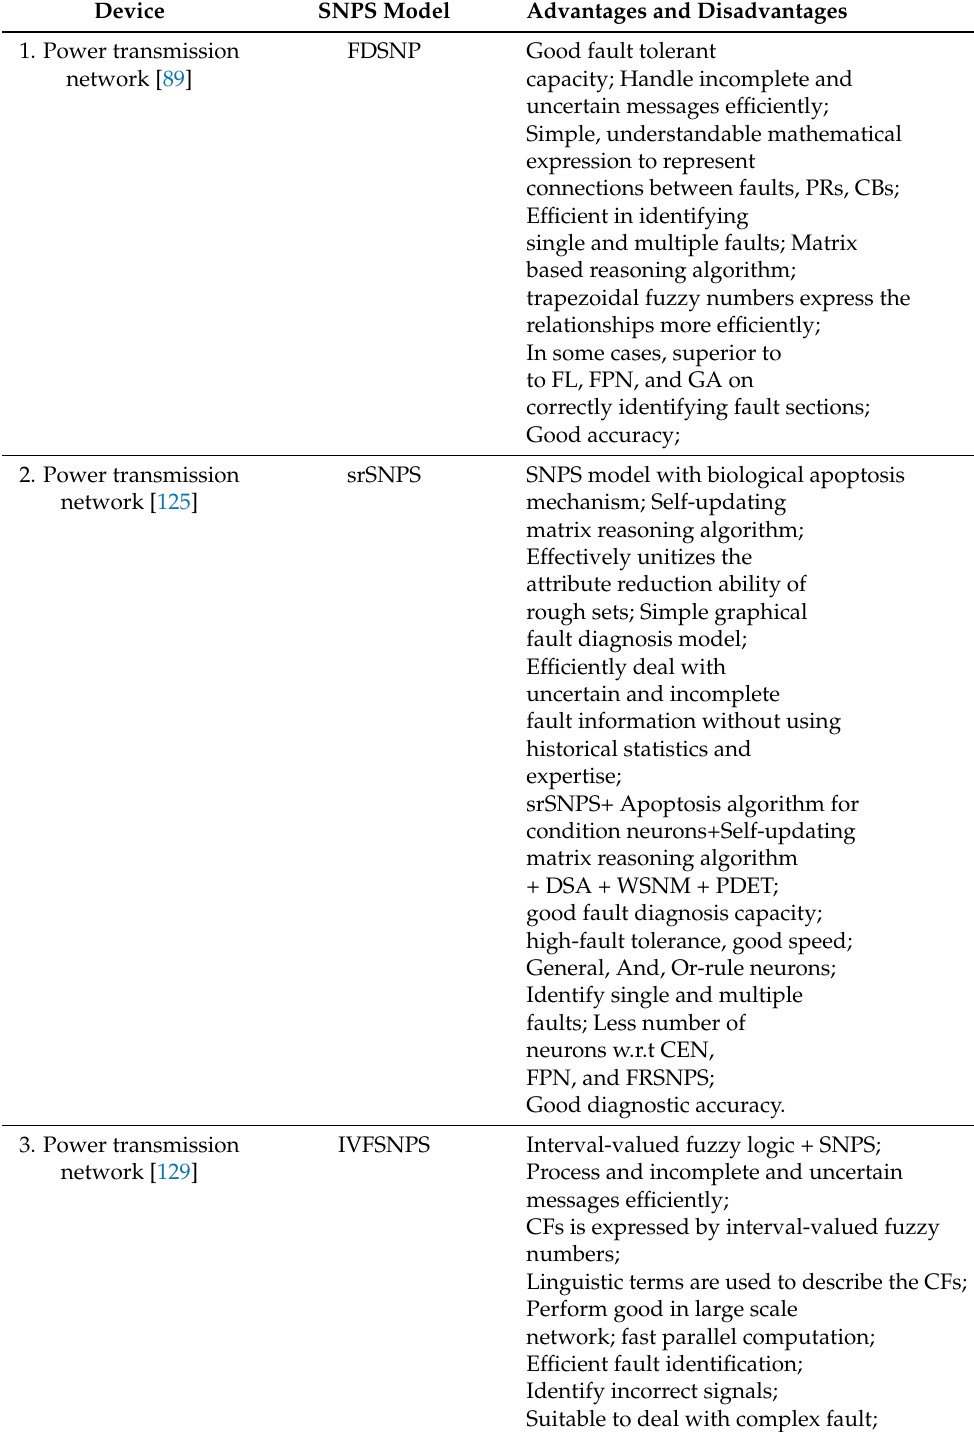
Table 4. Advantages and disadvantages of fault diagnosis models for power transmission networks with spiking neural P